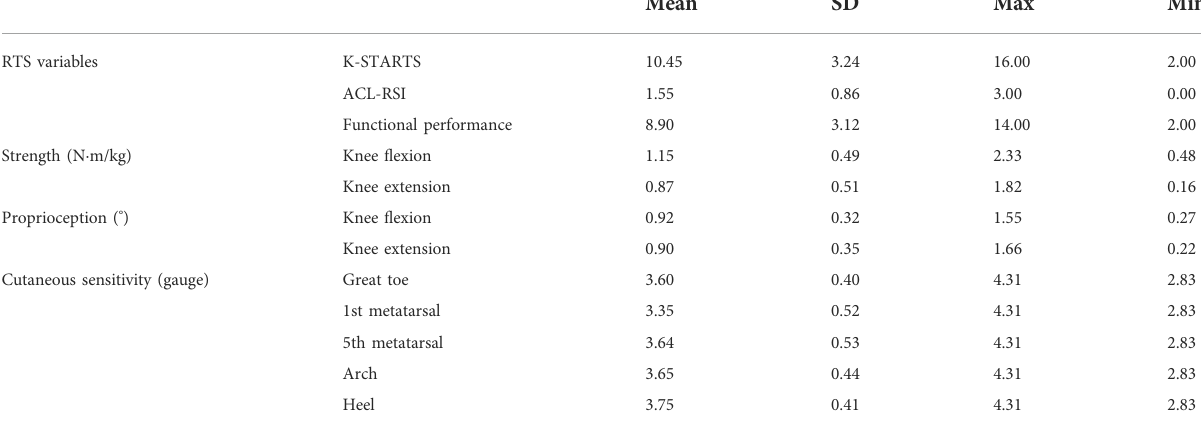
TABLE 1 Descriptive characteristics of outcome variables.